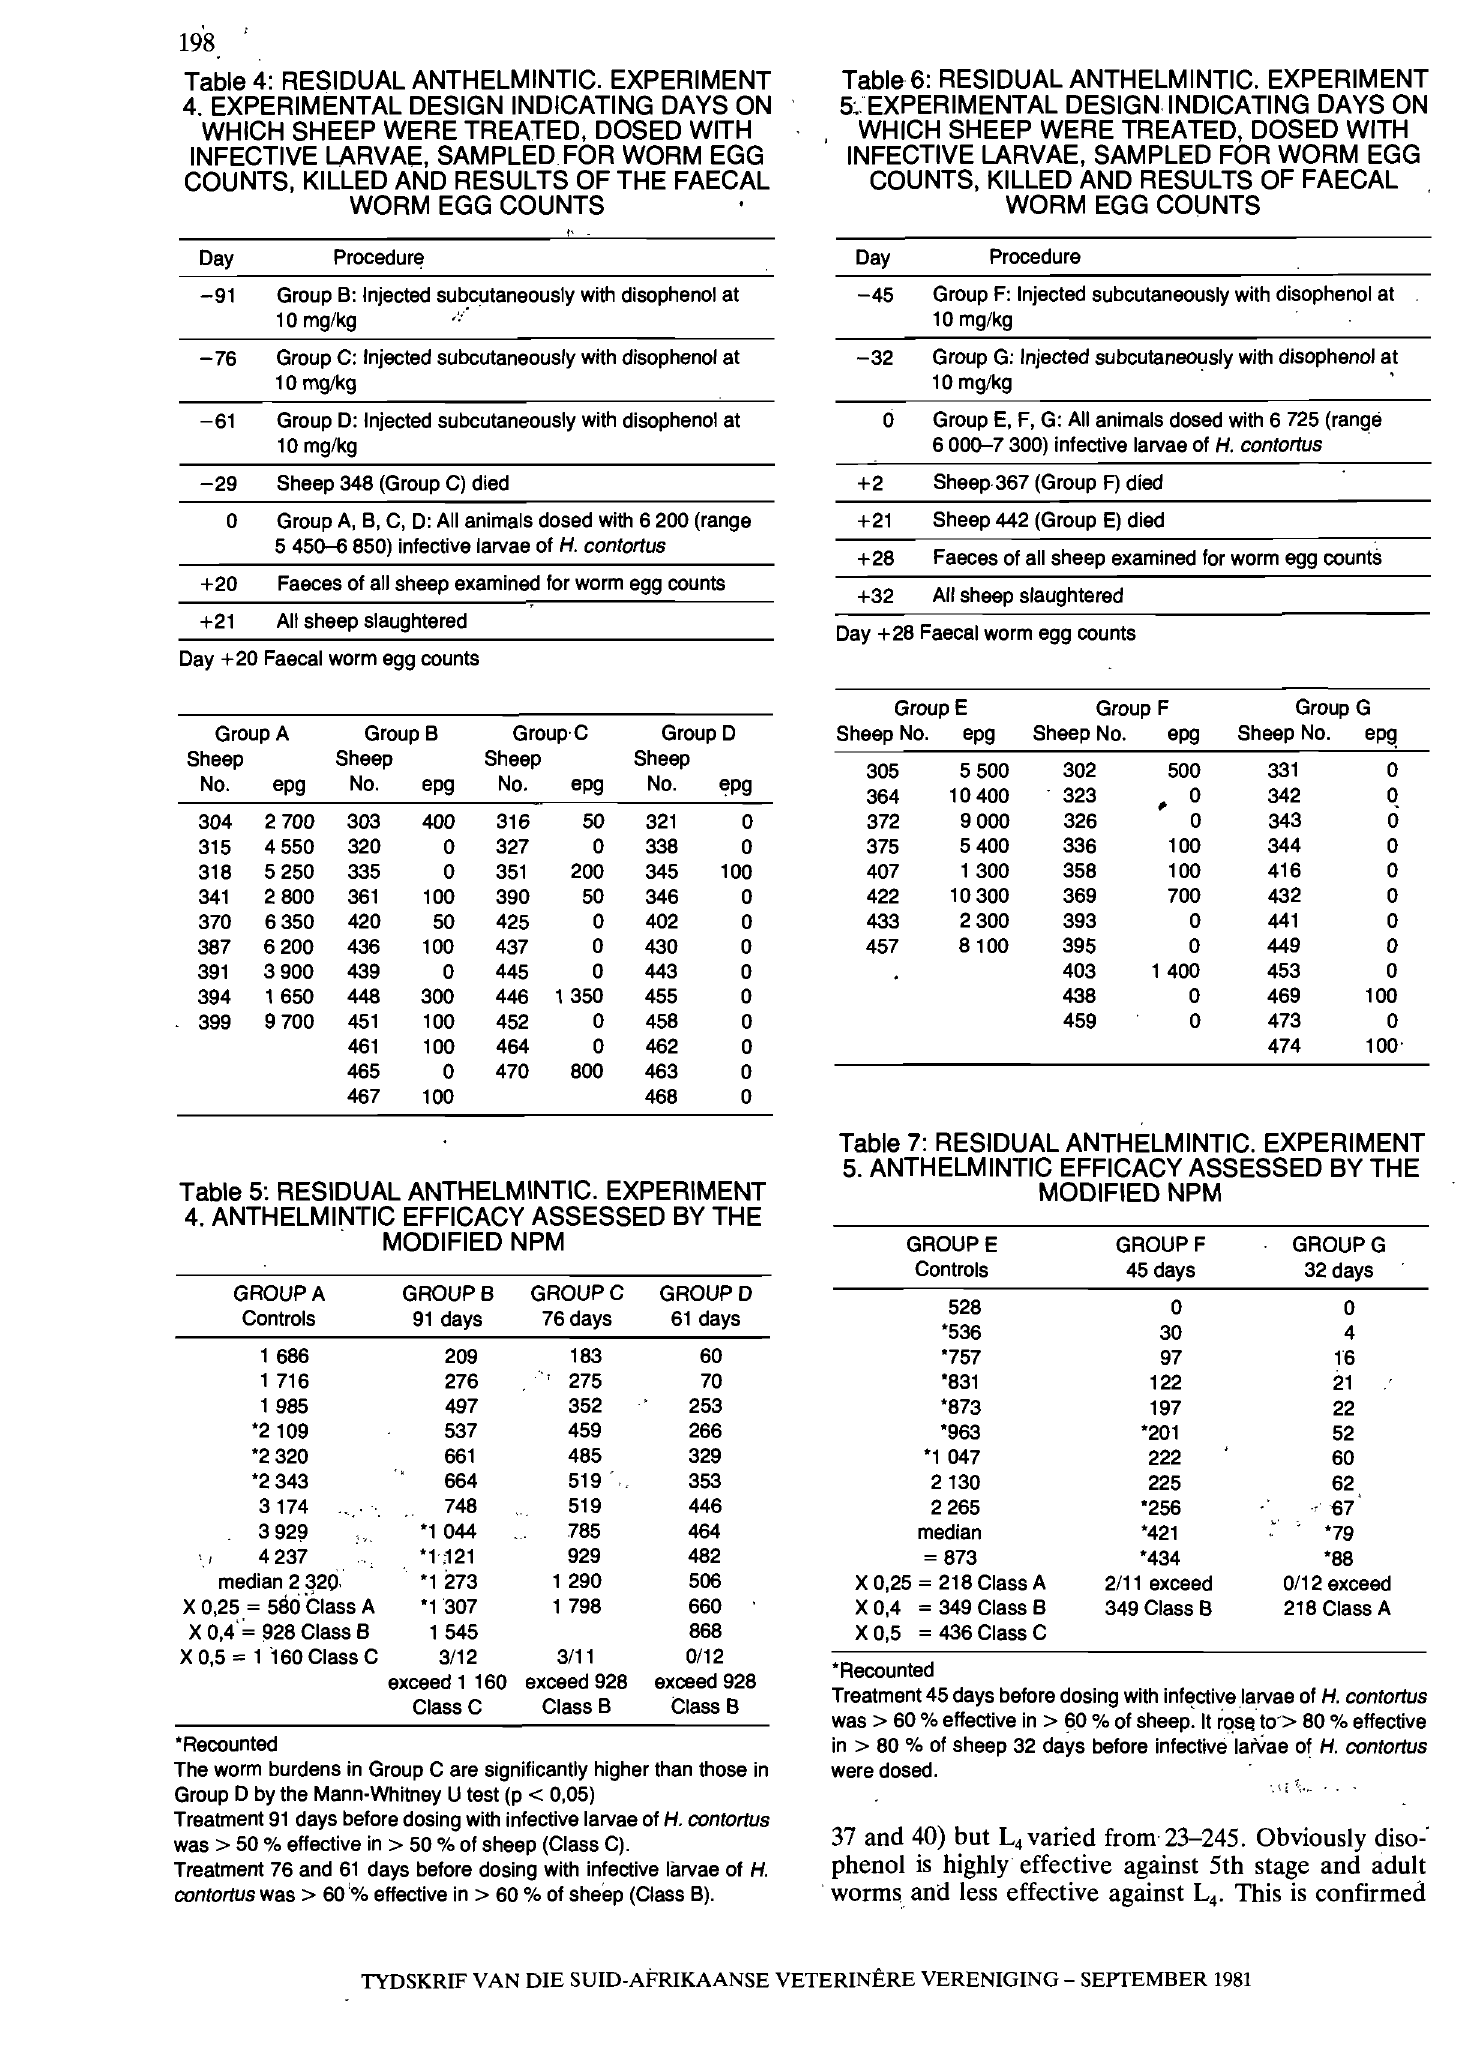
Table 4: RESIDUAL ANTHELMINTIC. EXPERIMENT 4. EXPERIMENTAL DESIGN INDICATING DAYS ON